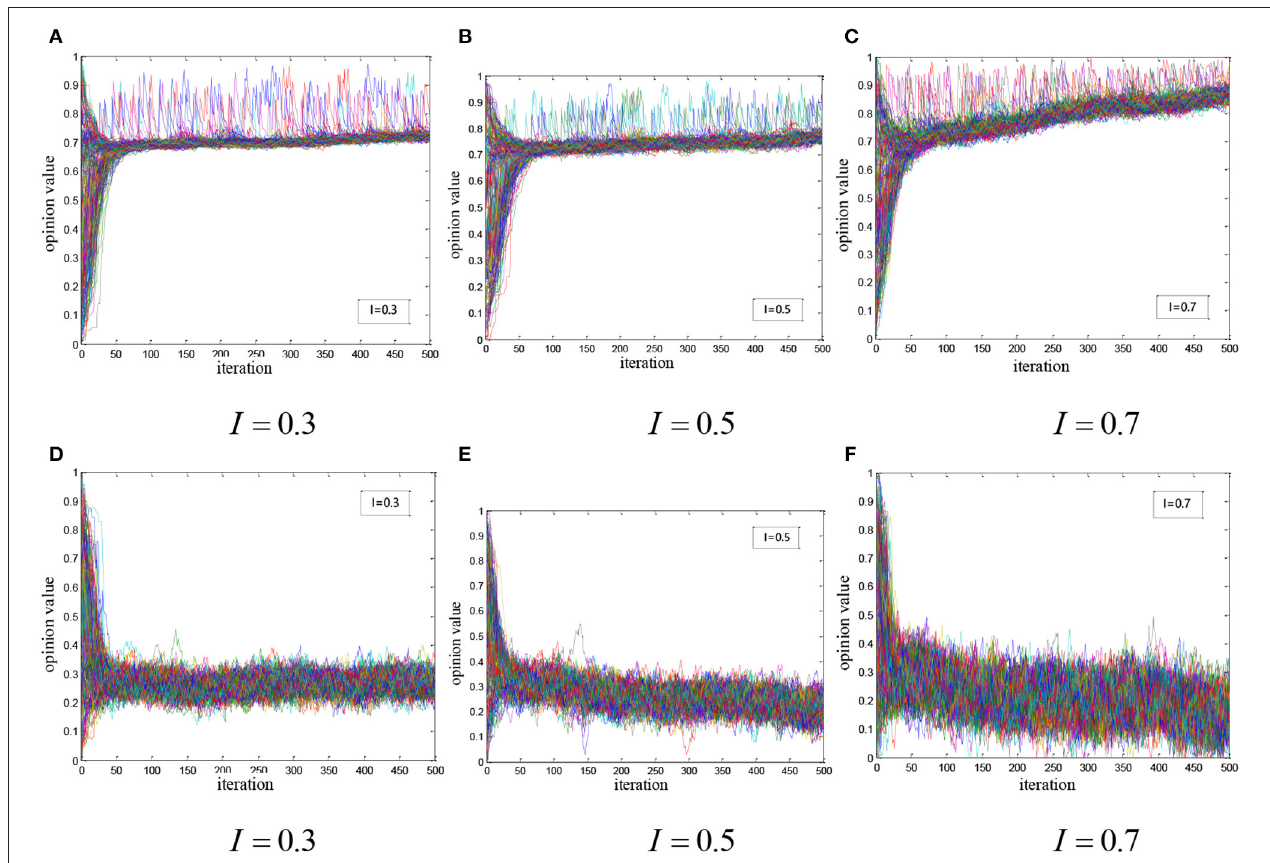
FIGURE 5 | Simulation of health opinion evolution based on elite silence: (A) I = 0.3; (B) I = 0.5; (C) I = 0.7; (D) I = 0.3; (E) I = 0.5; (F) I =